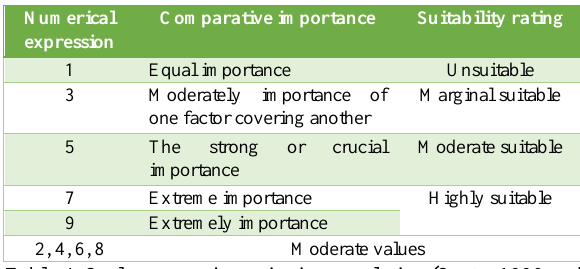
Table 4. Scale concerning pairwise correlation (Saaty, 1990 and 2006; Burnside et al. 2002)